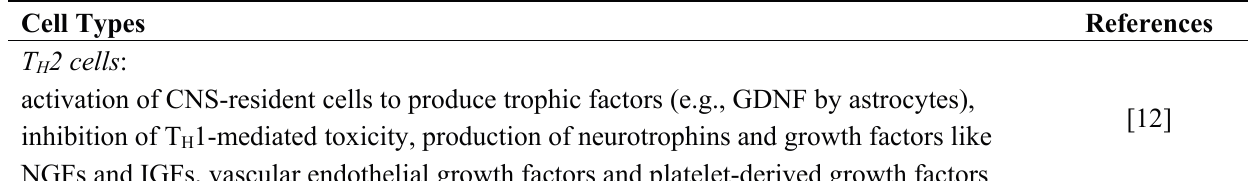
Table 2. Cell types/factors involved in neuroprotection and